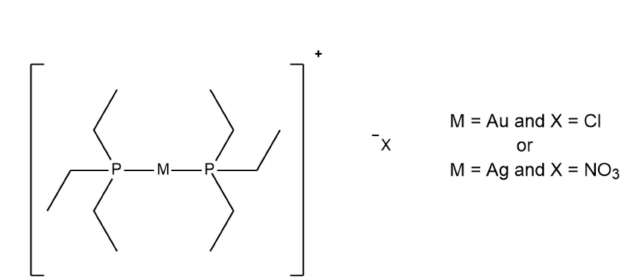
Figure 1. The panel of metal complexes studied in this work: Auranofin (reference compound), Au(I) and Ag(I) monophosphine derivatives of general formula M(PEt 3 )X and diphosphine derivatives of general formula [M(PEt 3 ) 2 ]X.